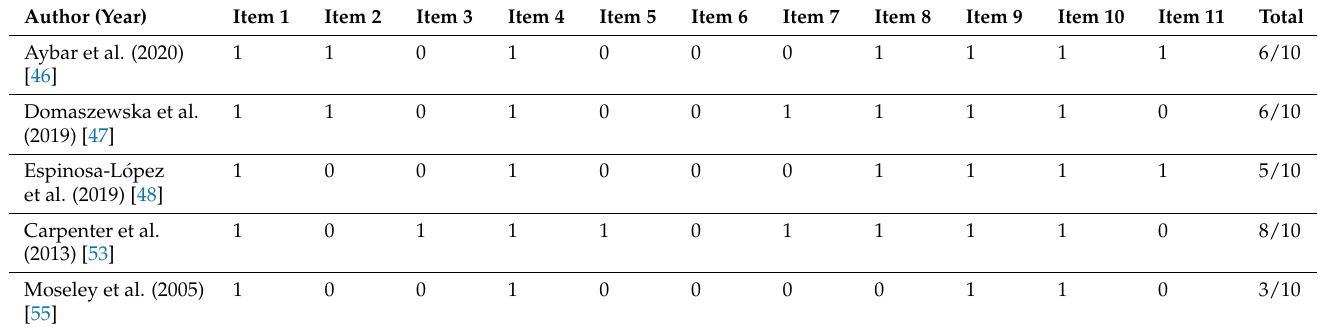
Table 2. Quality of Clinical Trials measured with the PEDro Scale.